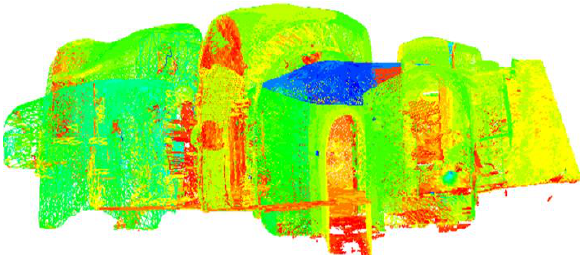
Fig. 13. Horizontal plan of the Kyiv Pechersk Lavra caves